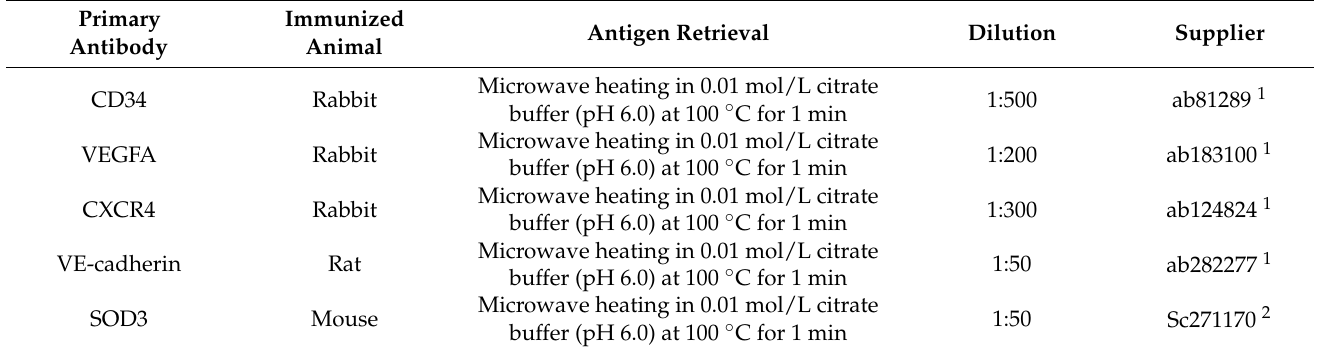
Table 1. Antibodies used in